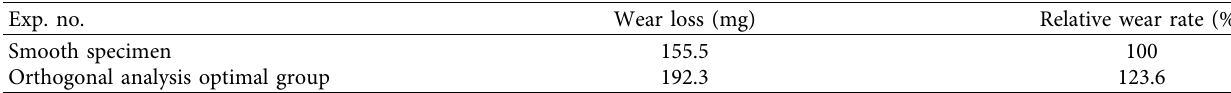
Table 6: Mass wear rate under dry friction conditions.